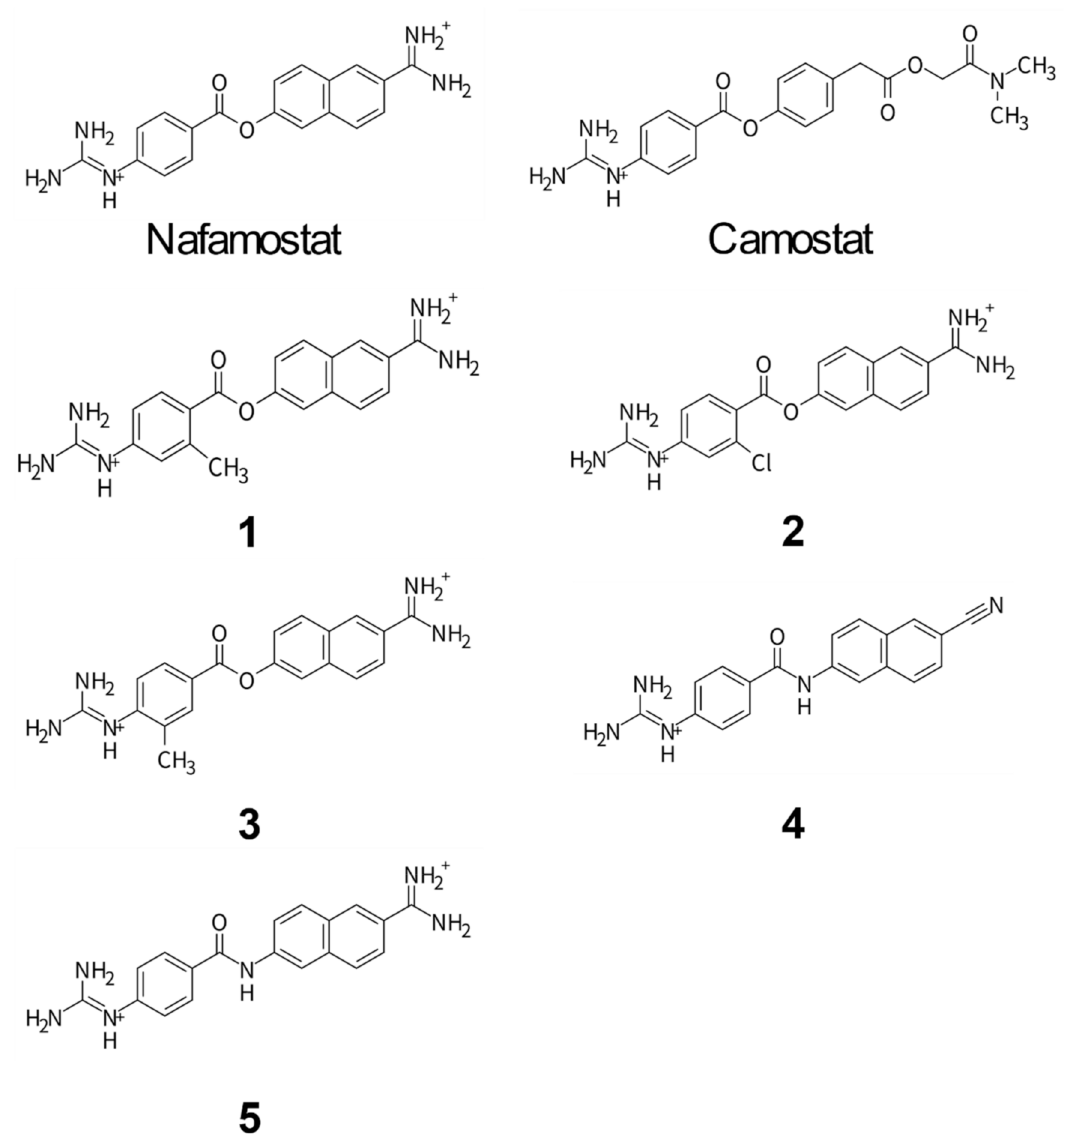
Figure 1. Chemical structures of nafamostat and its derivatives. Molecular docking simulations were performed using these compounds to obtain the binding conformations in the binding pocket of TMPRSS2. The binding affinities for these binding conformations were then evaluated using quantum chemical